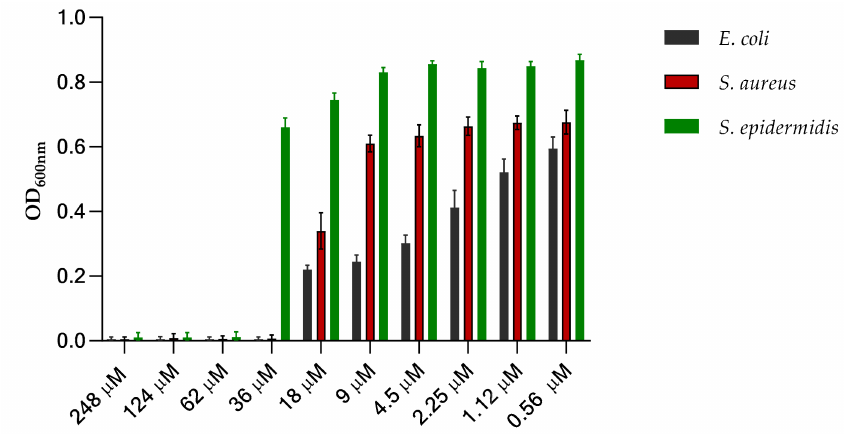
Figure 5. Determination of C-15867 minimum inhibitory concentration (MIC). All bacteria cells were grown in the presence of serial dilution of peptide from 248 µ M to 0.56 µ M and incubated at 37 ◦ C for 24 h. The error bars on the graphs stand for the standard deviation from the mean of three experiments.